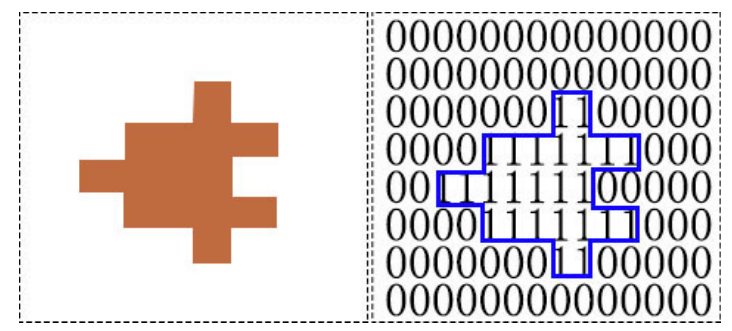
Figure 9. Binary image boundary search.